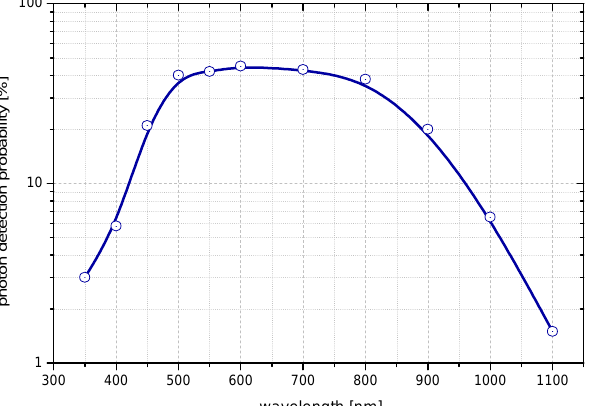
Figure 5. Typical detection probability versus wavelength [16] for a chip with a sensitive area of 20 µm and 1 V bias above breakdown voltage at room temperature.